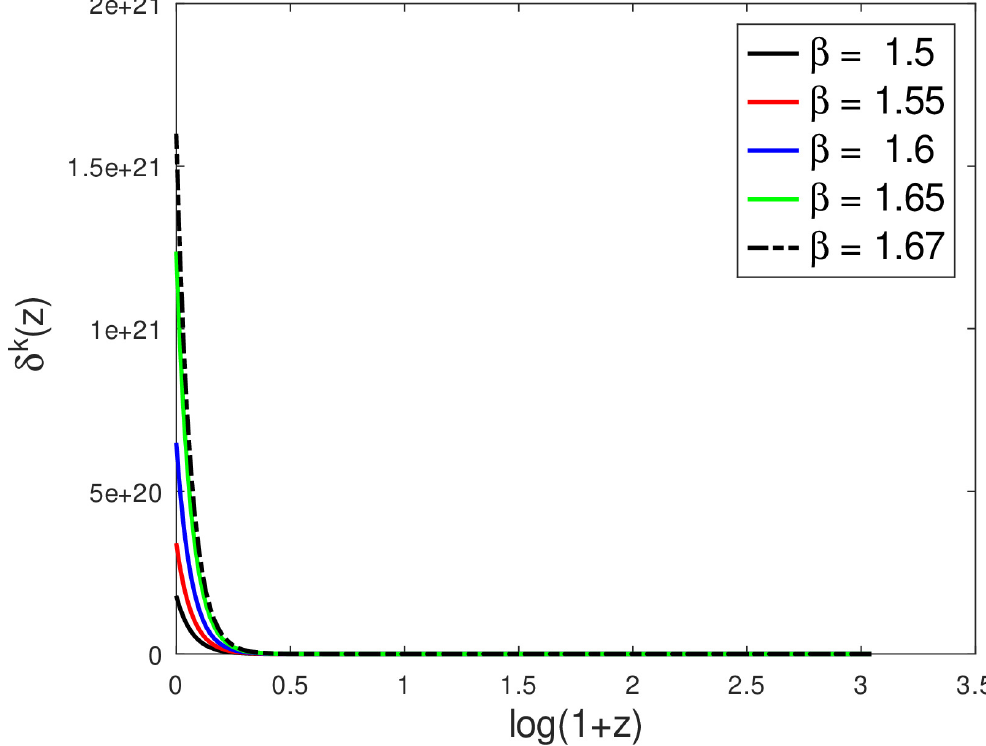
Figure 11. The variation of the matter density perturbations δ k ( z ) for a viscous Bianchi type-V cosmological model vs. redshift for γ = 4, α = 0.3, n = 0.2 and different values of β